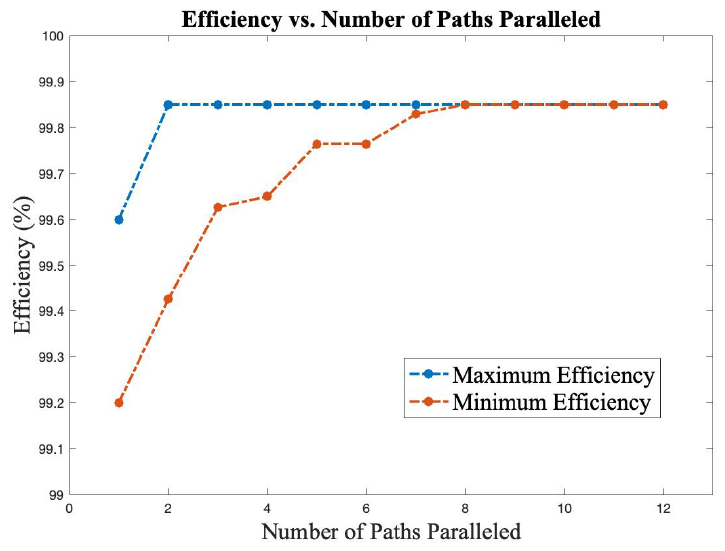
Figure 8. Maximum and minimum efficiencies for given number of paths paralleled for 3 × 3 lattice converter.